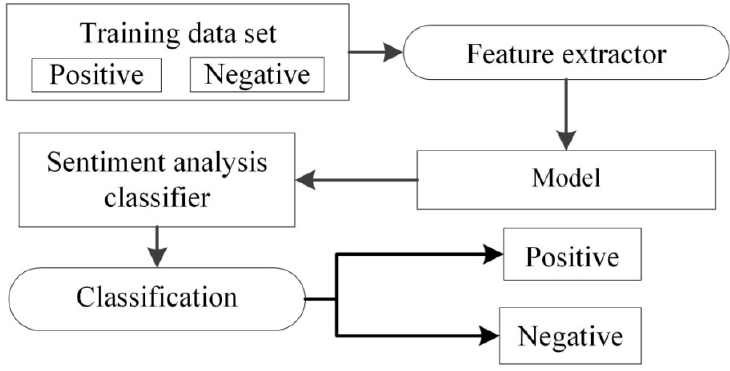
Figure 1. The structure of Twitter sentiment analysis.